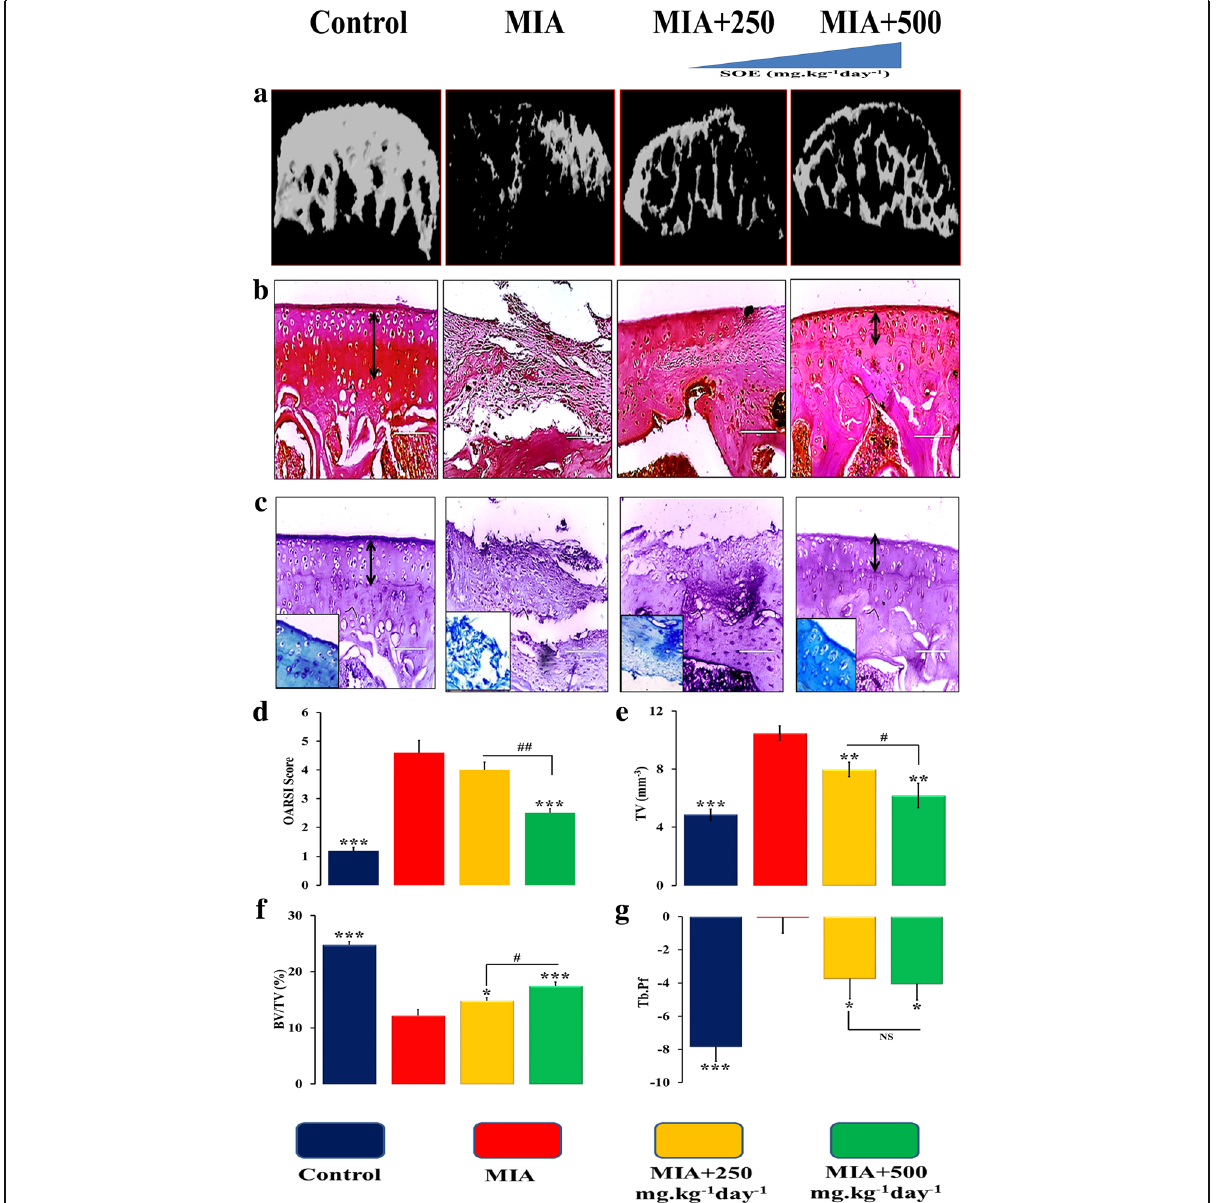
Fig. 4 Histological and dynamic histological analysis of articular cartilage and subchondral bone in experimental groups. a 3D μ -CT images of articular cartilage. b safranin-O staining ( c ) toluidine blue staining of sagittal sections of tibia. Double headed arrow showing hyaline cartilage and calcified cartilage ( d ) OARSI score from five different sections n = 3 per group. Micro-CT analysis of sub-chondral bone ( e ) total tissue volume (TV), ( f ) bone volume/tissue volume (BV/TV and ( g ) trabecular porosity (Tb. Pf). All values are expressed as Mean ± S.E.M. ( n = 6/group); * P < 0.05, ** P < 0.01, *** P < 0.001 compared to the MIA group # P < 0.05, ## P < 0.01, compared to the 250 mg.kg − 1 day − 1 dose, NS= non